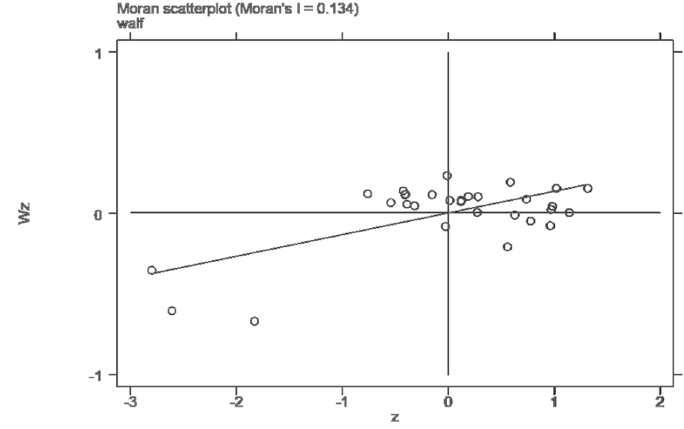
Figure 4. Local Moran scatter plot of residents’ well-being in 2018.